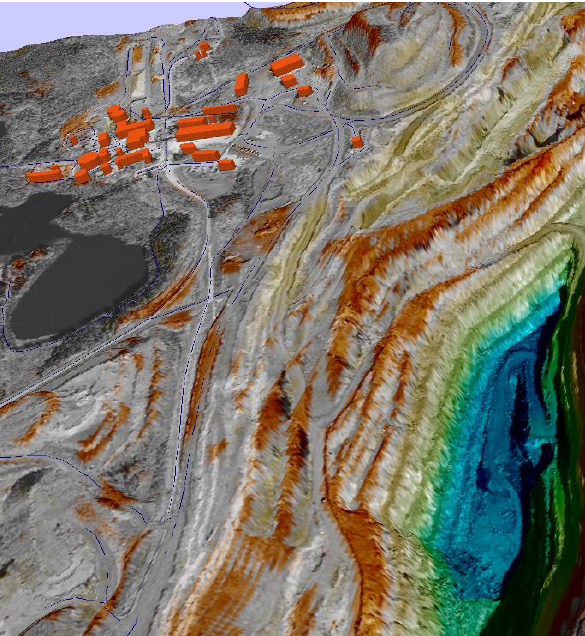
Figure 3: Example of visualisation of volume changes in open pit mine area between the years 1998 and 2012. Colors indicate change in volume (red: positive, blue & green: negative). Road network and buildings modelled with LOD1 polygons.